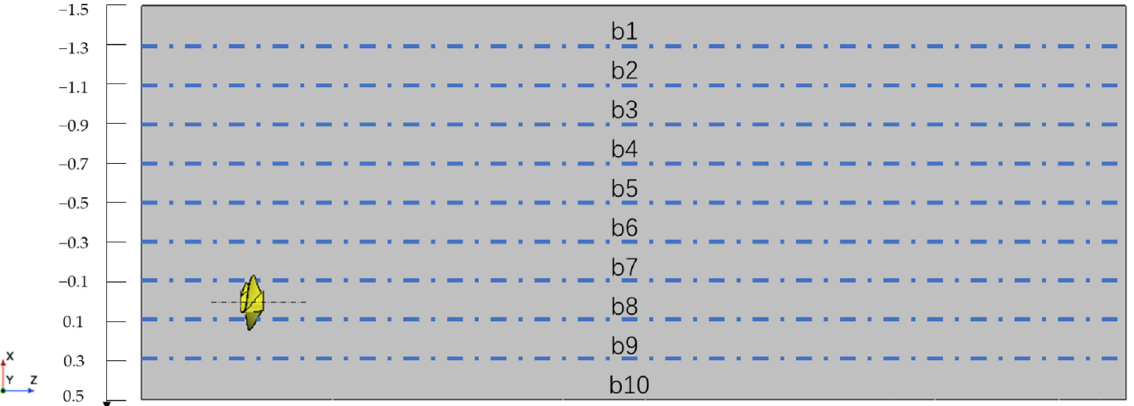
Figure 16. Number of particles in a1~a10.